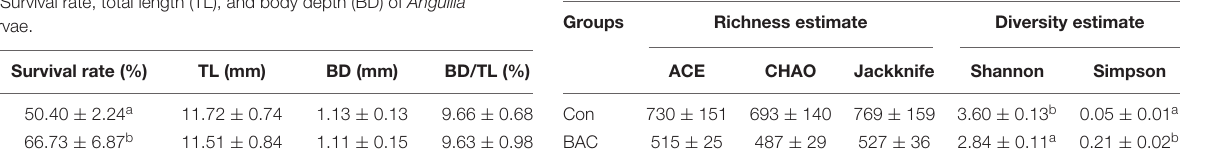
TABLE 2 | Alpha diversity of the bacterial communities of A. japonica larvae.